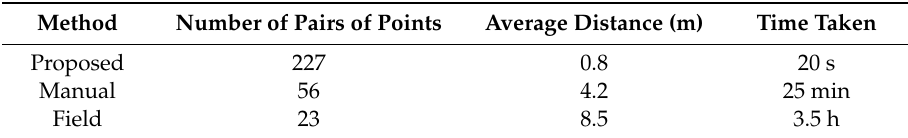
Table 2. Manual, field, and proposed methods statistics.